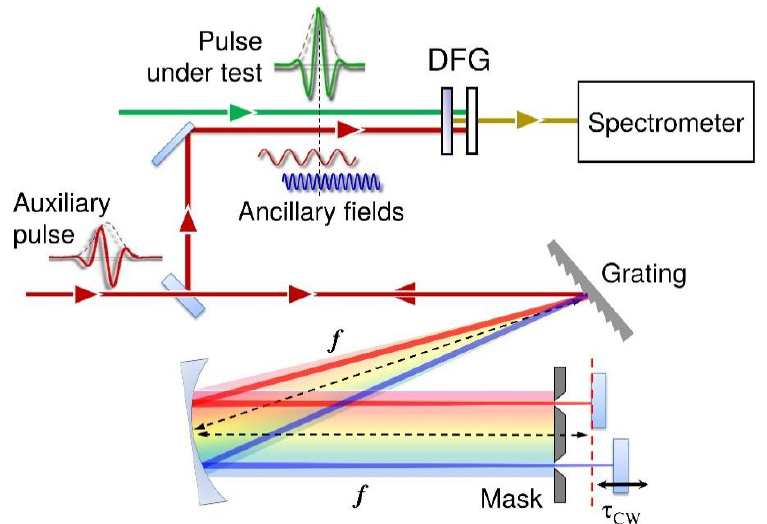
Figure 2. Modified scheme of the 2DSI technique used for the characterization of the UV pulses.